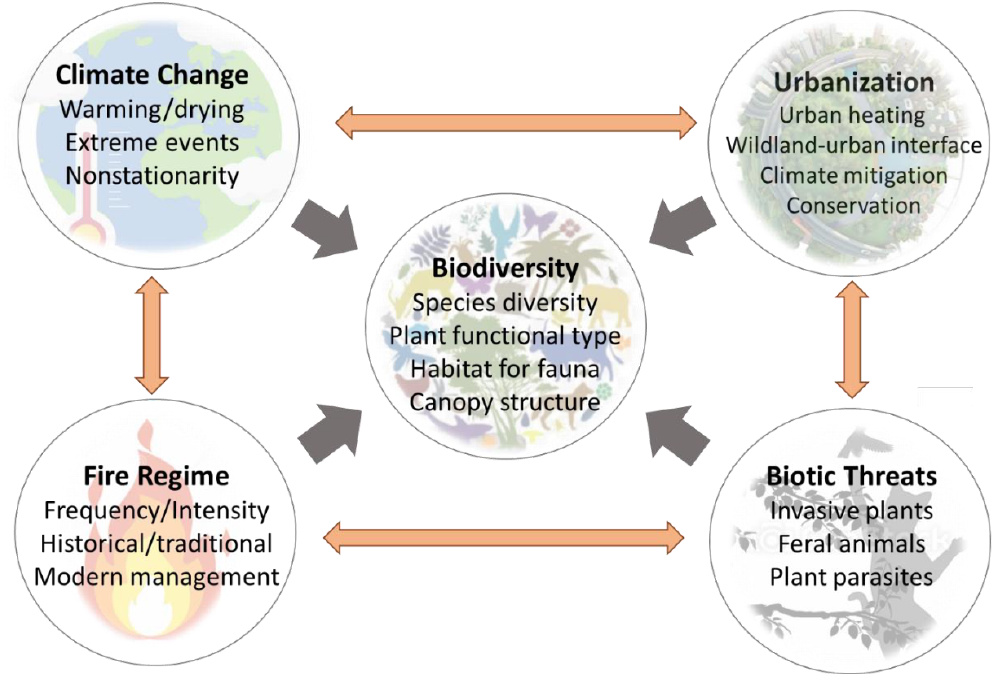
Figure 1. Conceptual figure showing the compound/interacting threats to biodiversity, including species composition, plant functional type, habitat and canopy structure, in peri-urban forests of southeast Australia and globally. In mid-latitudes climate warming, drying and extreme events are becoming more common, leading to nonstationarity, in which future conditions cannot be predicted from the past. Fire regimes have become more intense, while recognition of traditional (indigenous) management is increasing. Urbanization is associated with challenges of development at the wildland–urban interface and urban heat islands, but these can be mitigated with adaptive conservation planning and policies. Biotic threats may require more aggressive management in some cases. The biggest uncertainties for biodiversity protection may be related to the interactive nature of all these threats.